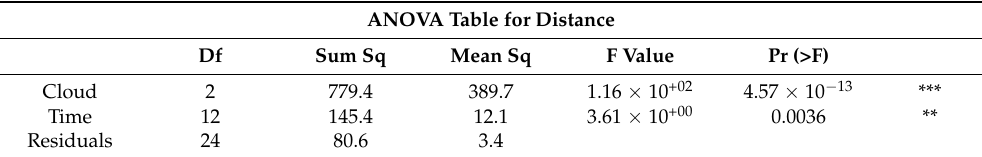
Table 6. ANOVA Table for Distance on clouds for different virtual machines .